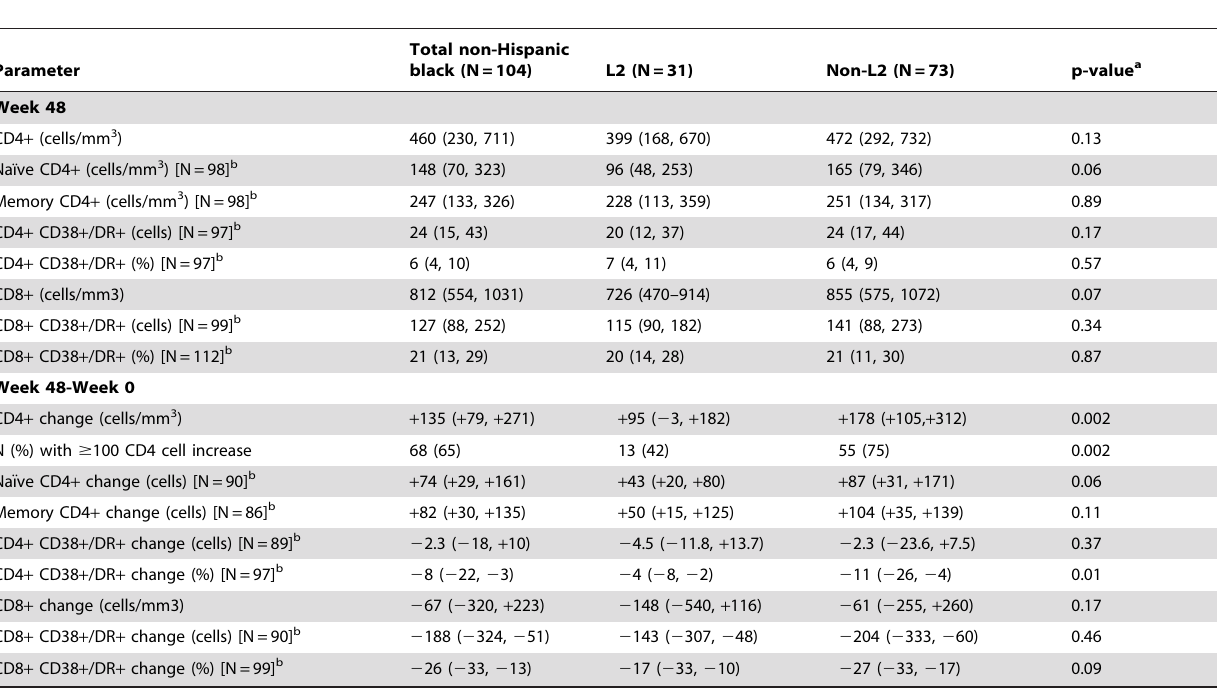
Table 3. T cell parameters at 48 weeks and 48 week changes among the black, non-Hispanic ACTG 384 population with baseline CD4 activation markers and 48 week HIV RNA , 400 copies/mL, total and by African L2 and non-L2 mtDNA